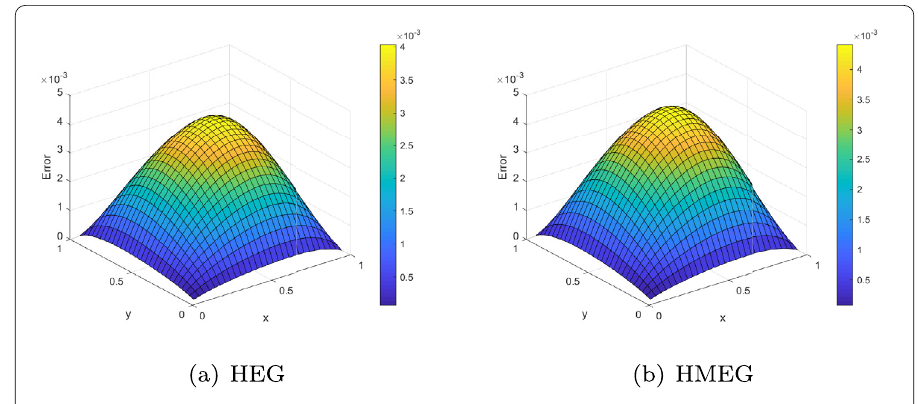
Figure 6 The graphical error representation of the HEG and HMEG methods at α = 0.3, h = 1/30 for Example 5.1